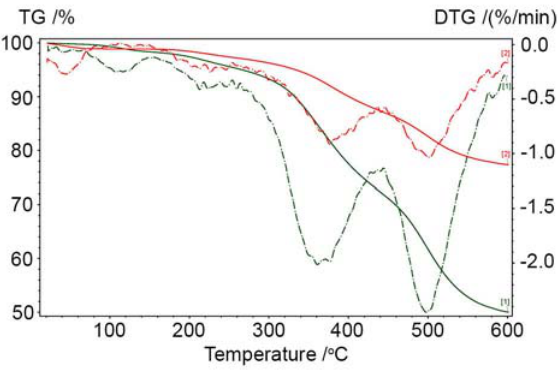
Figure 2. Thermogravimetric (TGA–solid line) and differential thermogravimetric (DTG–dash-dot line) curves of (1) L-prol-N-p- TMS and (2) L-prol-N-pMCM-41 samples.